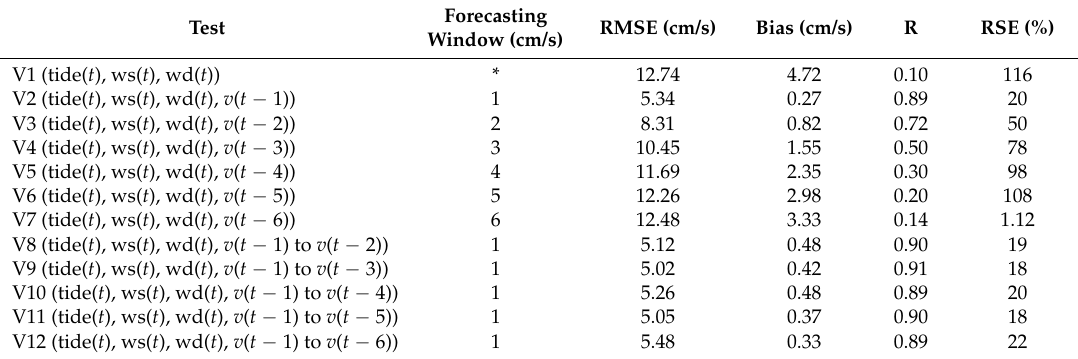
Table 5. Averaged statistics of v velocity component at ten points (testing